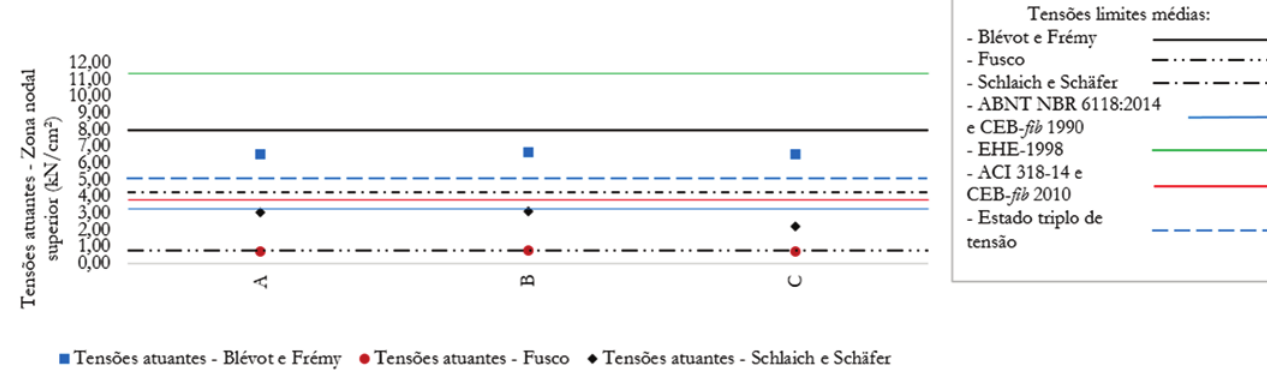
Modelos ensaiados por Chan e Poh [7] × σ